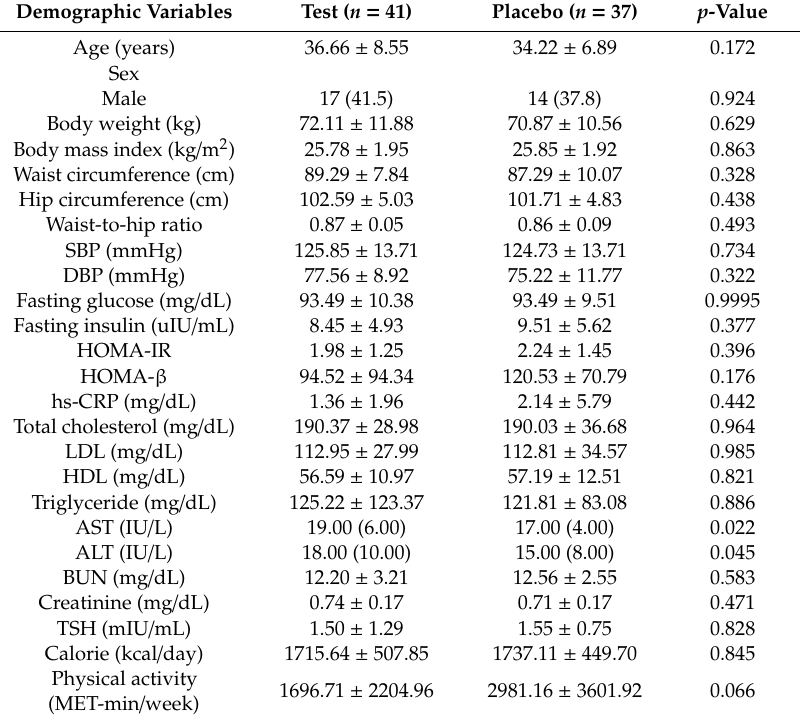
Table 1. Demographic and baseline characteristics of the study population.